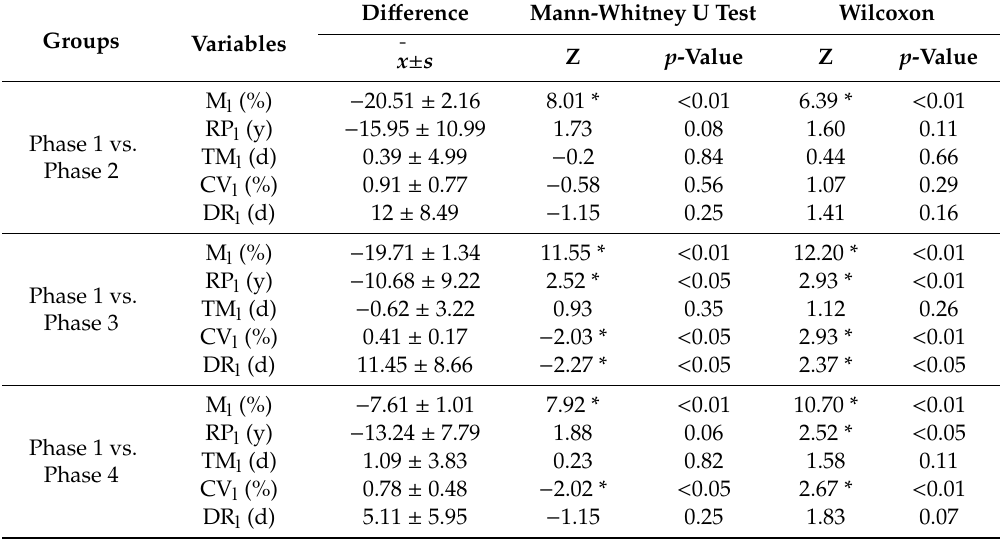
Figure 6. An example of flow duration curve for pair 1961 vs. 1991 in Phase 1 and Phase 4 (flow duration curves for other selected pairs in forest recovery period can be found in Figure A3). Table 7. The comparison of low flow regime components in di ff erent phases during the forest harvesting period by statistical